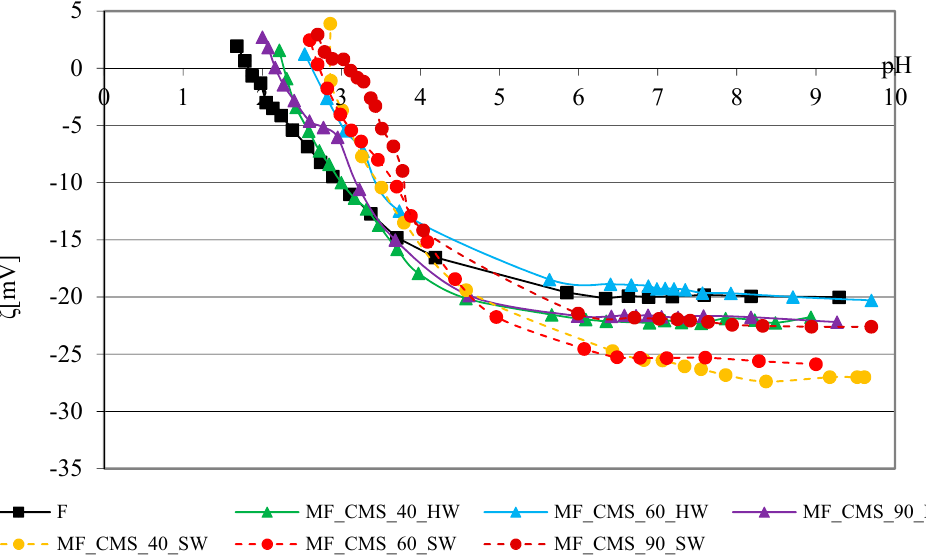
Figure 5. Zeta potential of cotton fabrics before and after 10 cycles of modification with detergent with CMS in hard and soft water at 40, 60 and 90 ◦ C depending on the pH of 1 mmol/L